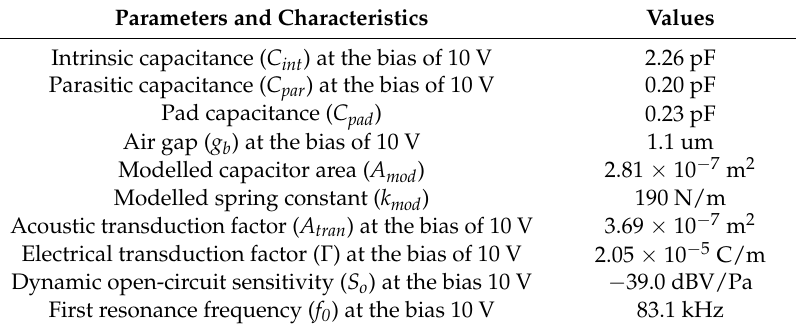
Table 2. Modelled parameters and variables for a capacitive MEMS acoustic